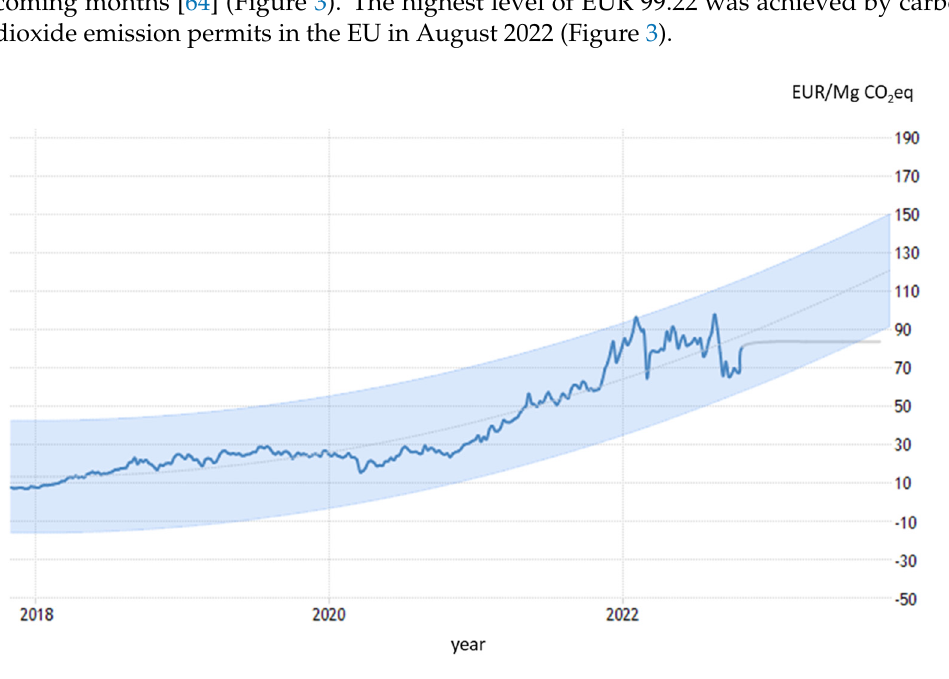
Figure 3. Forecast of EU Carbon Permits (modification based on [64]).